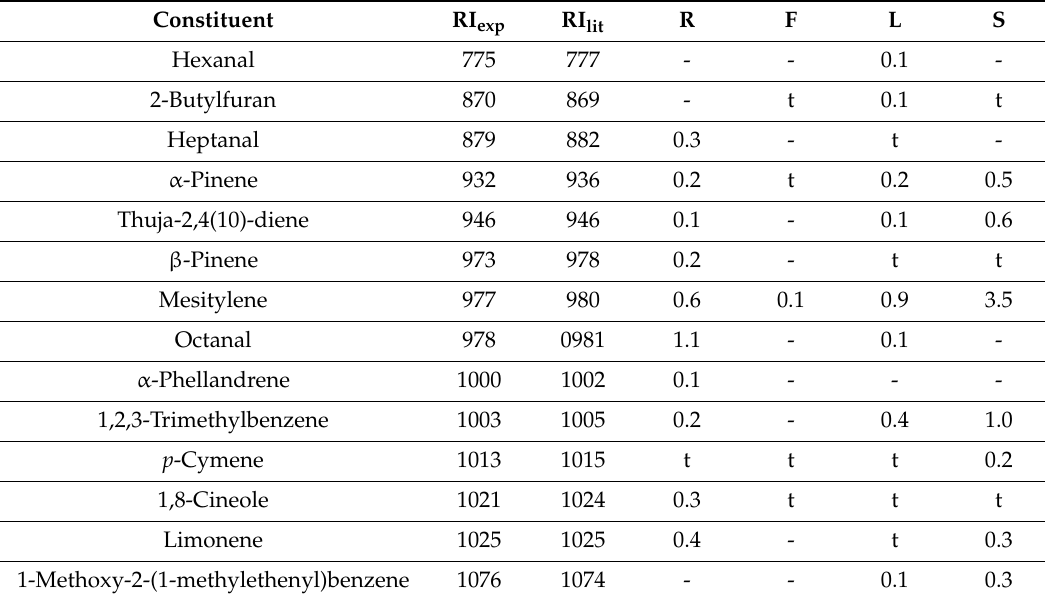
Table 1. The chemical composition (%) of the essential oil from di ff erent organs of the intact plant and in vitro shoot culture of E. maritimum